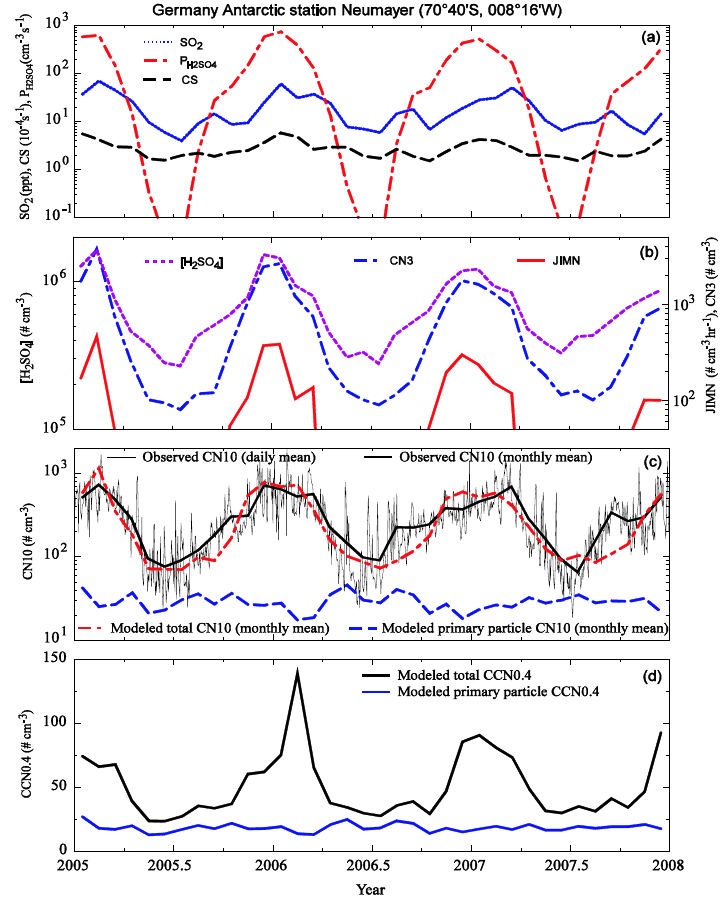
Figure 3. Simulated monthly mean [SO CCN0.4 during a 3-year period (2005/01–2007/12) at the Neumayer station (70°40’S, 008°16’W). The daily and monthly mean CN10 data from the German Antarctic station Neumayer are plotted in Figure 3c for comparisons. In addition to total CN10 and CCN0.4, the contributions of primary particles (including sea salt, BC, POC, and dust) to CN10 and CCN0.4 are also shown in Figures 3c and